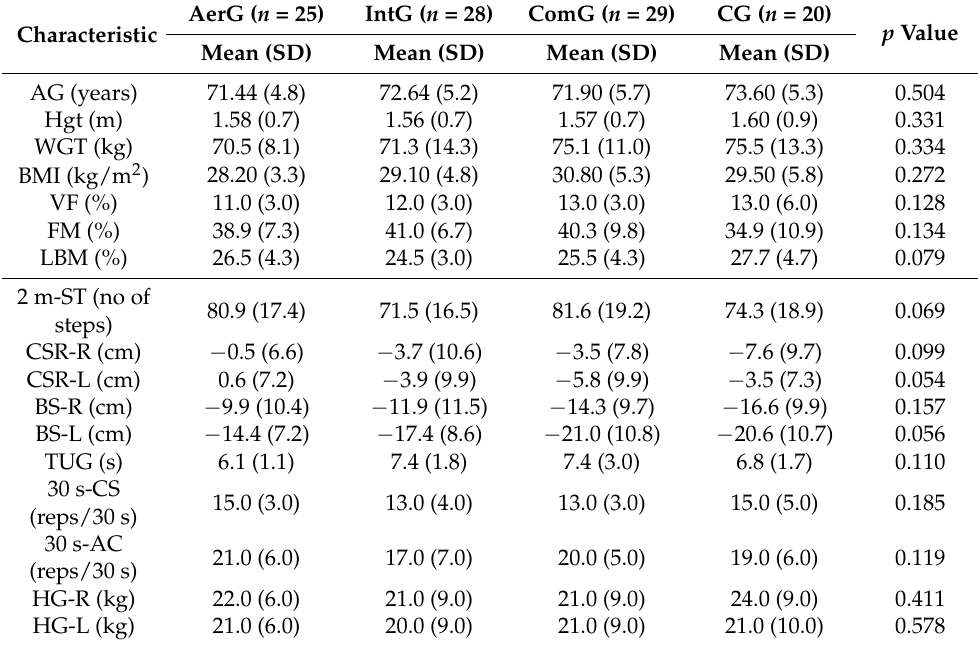
Table 1. Characterization of the baseline sample (M1).